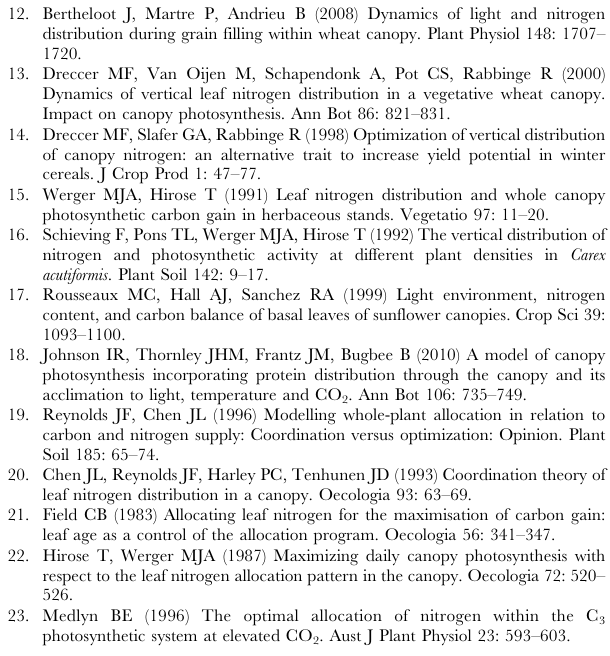
Table S2 Range of the observed values among literature of the parameters used in the leaf photosynthesis – stomatal conductance model. The categories were the minimum, the maximum, the median and the percentage of variation of parameters range. The sources of observations were also reported. The sources, where the minimum and maximum values were observed, were annotated with – and + . A reference temperature of 20 u C was used. Table S3 Multiple regression analyses of Vc max and J max from environmental growth conditions for the bootstrap analysis. Independent variables: X 1 : air CO 2 concentration ( C g ); X 2 : N level; X 3 : soil H 2 O level; X 4 : radiation ( PPFD ); X 5 : air growth temperature ( T g ); X 6 : air relative humidity ( h s ). The number of observations was 236. Table S4 Multiple regression analyses of k 3 and J fac from environmental growth conditions for a bootstrap analysis. Independent variables were the same as Table S3. The number of observations was 236. Table S5 Prediction of W c and W j ( m mol m 2 2 s 2 1 ) in using the parameters Vc max and J max calculated from regression analyses on the independent part of the dataset in a bootstrap analysis (Table S3). Characteristics of the W c/ W j relationship. The intercepts of regression for each PFT were set to zero (since there were not significantly different from zero) to estimate the slopes. RRMSE: relative root mean square error. Table S6 Prediction of N ac in using the parameters k 3 and J fac calculated from the regression analyses on the